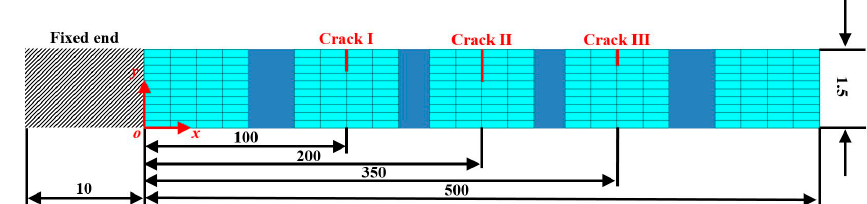
Figure 2. Numerical model of the CFRP laminated beam with three cracks, the dimensions of which are in millimeters (the blue sections are used to display the intact segments of the beam).